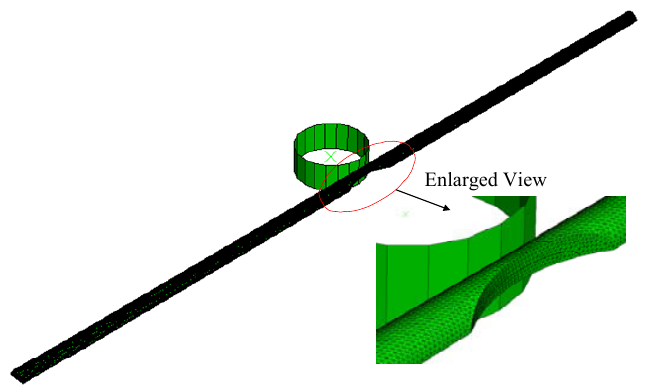
Figure 3. Finite element model of grooved POF